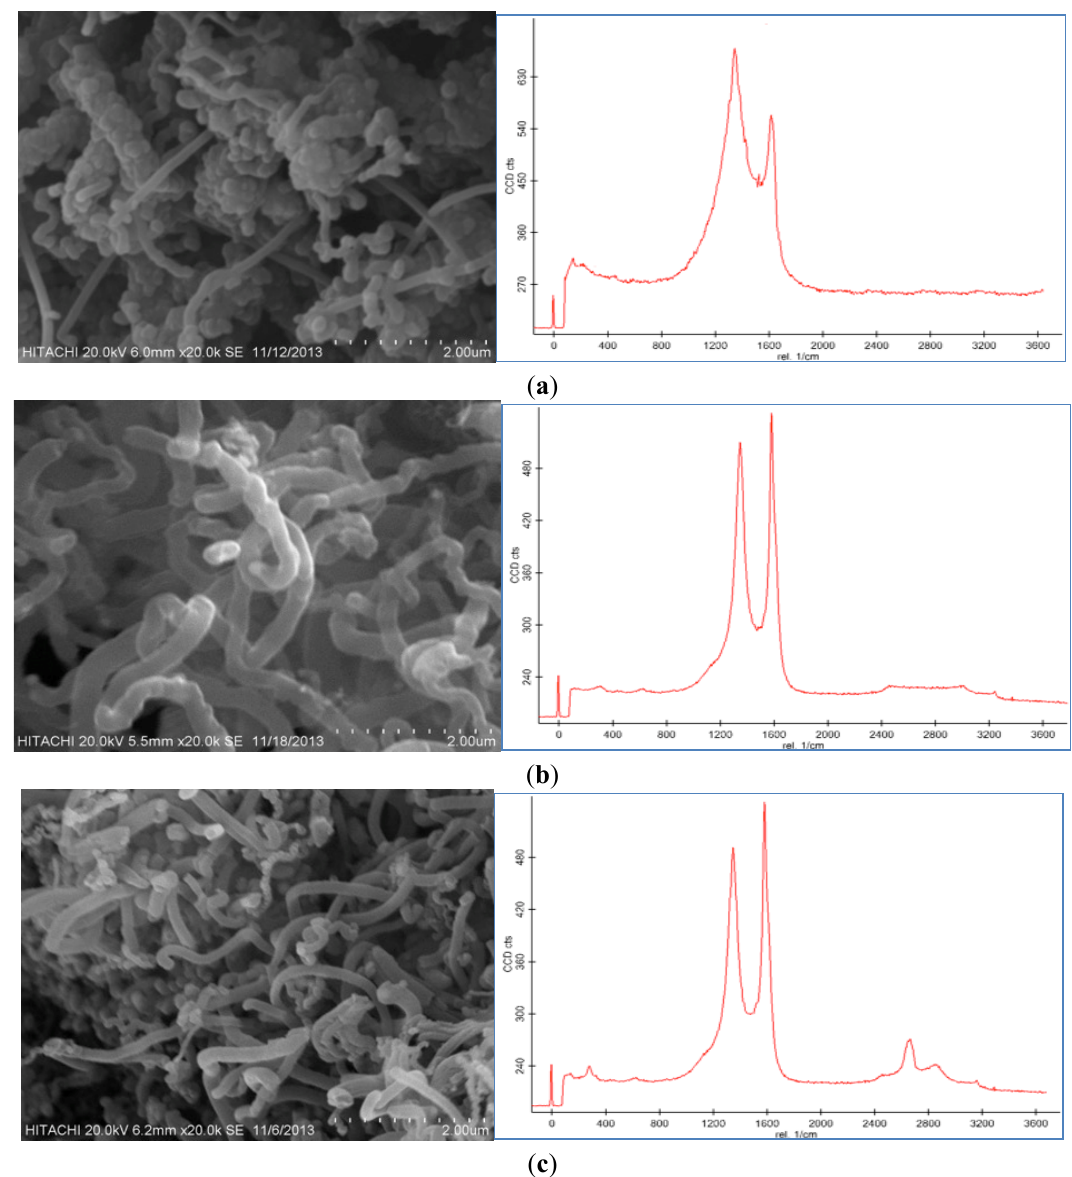
Figure 3. SEM images and Raman spectra of grown CNF by use of 100 mM catalyst concentration for 30 min under 50 sccm acetylene flow rate at ( a ) 450 °C, ( b ) 550 °C, and ( c ) 650 °C.